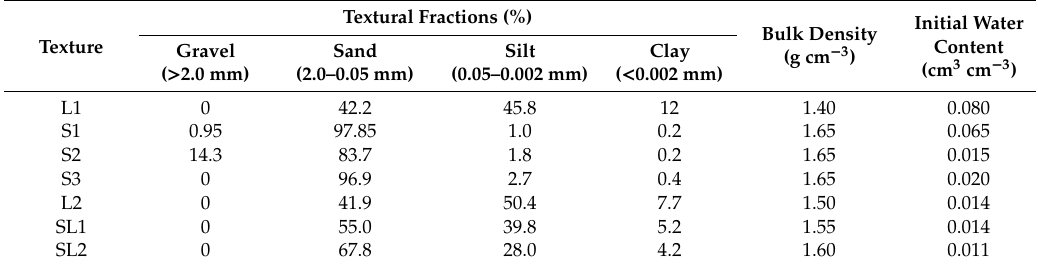
Table 1. Soil particle size distribution, bulk density, and initial water content for column infiltration